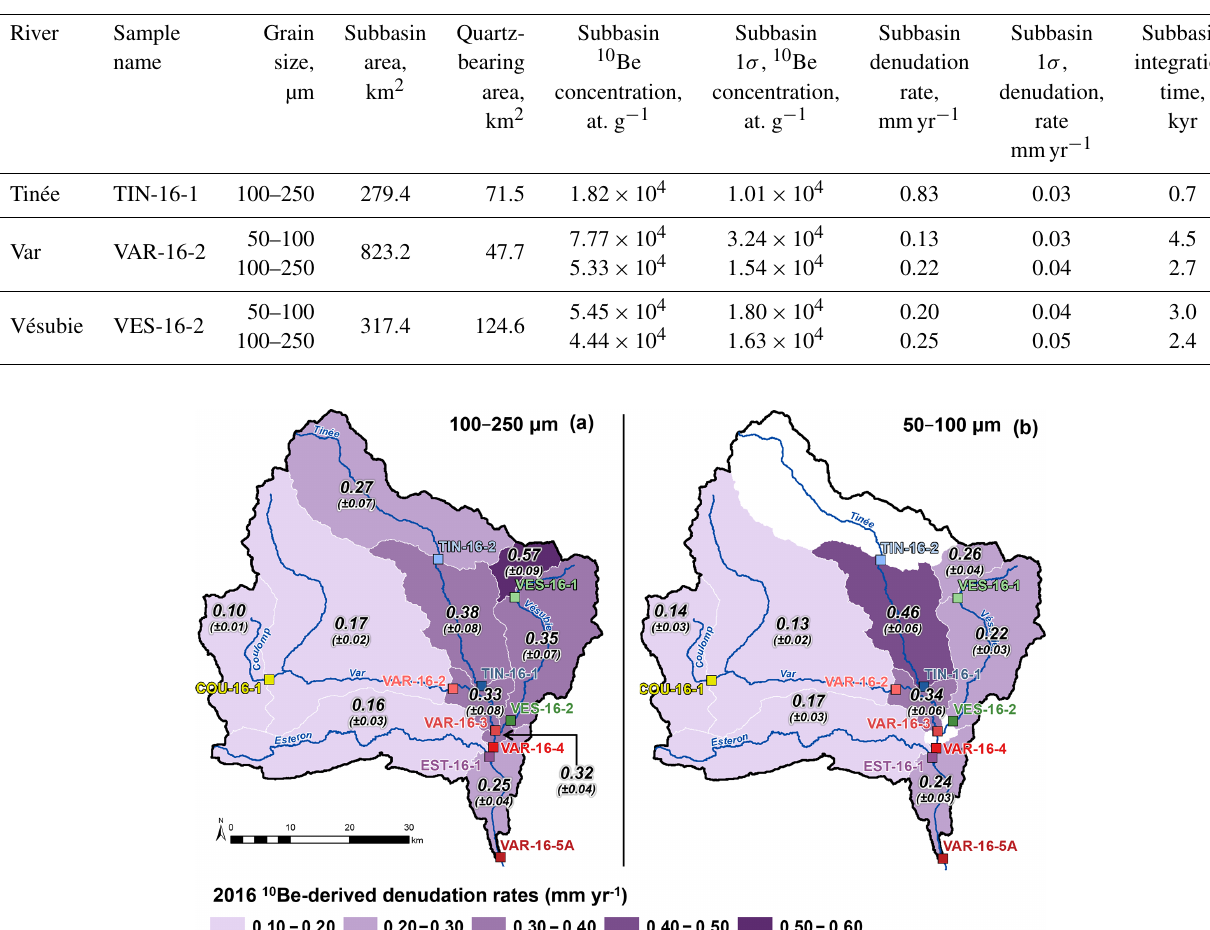
Table 2. Subbasin 10 Be concentrations and denudation rates in the Var basin in 2016. These effective denudation rates were calculated by excluding nested upstream subbasins following the method of Portenga et al. (2015). Denudation rates were calculated with neutron, fast muon, and slow muon attenuation lengths of 160, 4320, and 1500gcm − 2 , respectively (Braucher et al., 2011) and assuming a rock density of 2.7gcm − 3 . Integration time represents the time required to remove 60cm of bedrock.